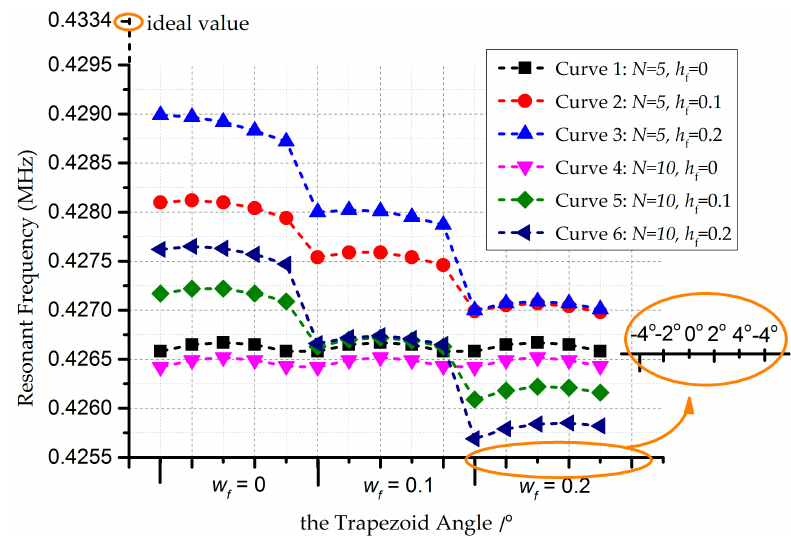
Figure 8. Change curves of the resonance frequency for the modified model of the doubly-clamped beam. The x coordinate is divided into three intervals, each of which is denoted as magnified in the orange circle.